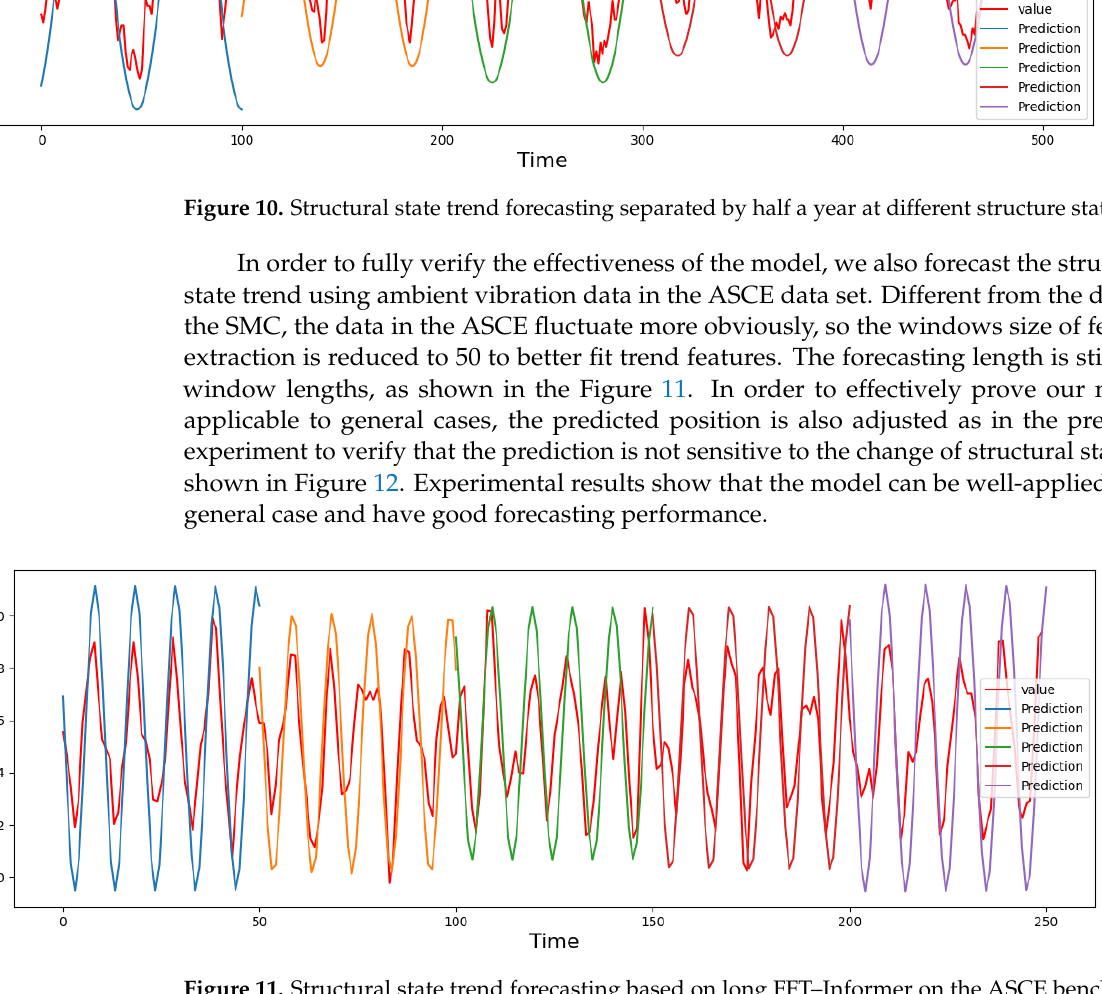
Figure 11. Structural state trend forecasting based on long FFT–Informer on the ASCE benchmark data